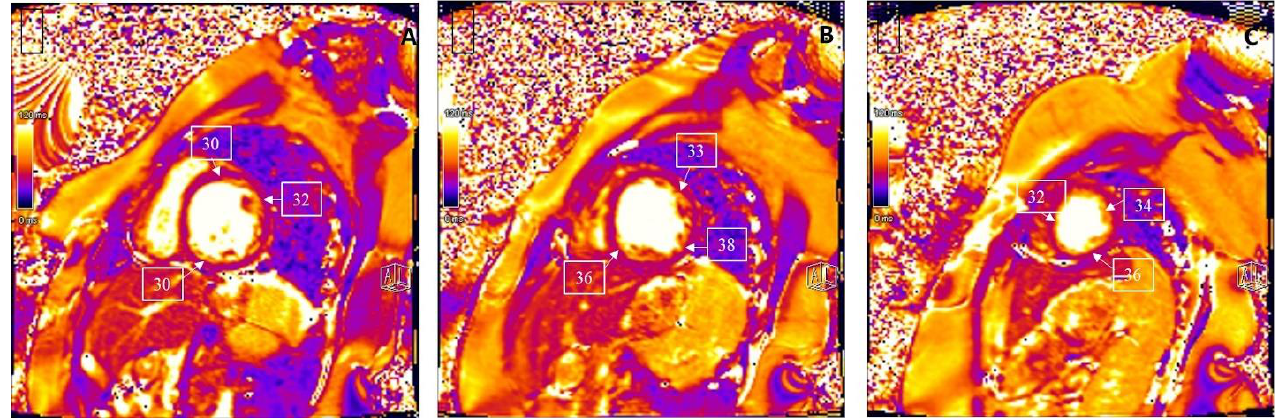
Figure 6. T2 mapping demonstrating normal myocardial T2 relaxation times at the base ( A ), mid- ventricular level ( B ), and at the apex ( C ). Clinical vignette: 12-year-old female with possible chronic myocarditis associated with Parvovirus B19, dilated LV with decreased LVEF 22%.